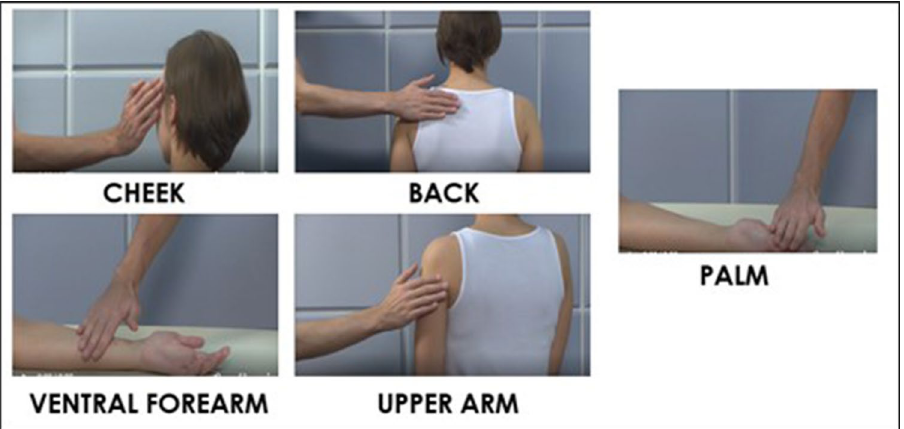
Figure 1. Visual illustration of the 5 body sites (CT-innervated body regions: Ventral Forearm, Upper Arm, Cheek and Back vs. the non-CT innervated palm) from the affective touch videos used in this